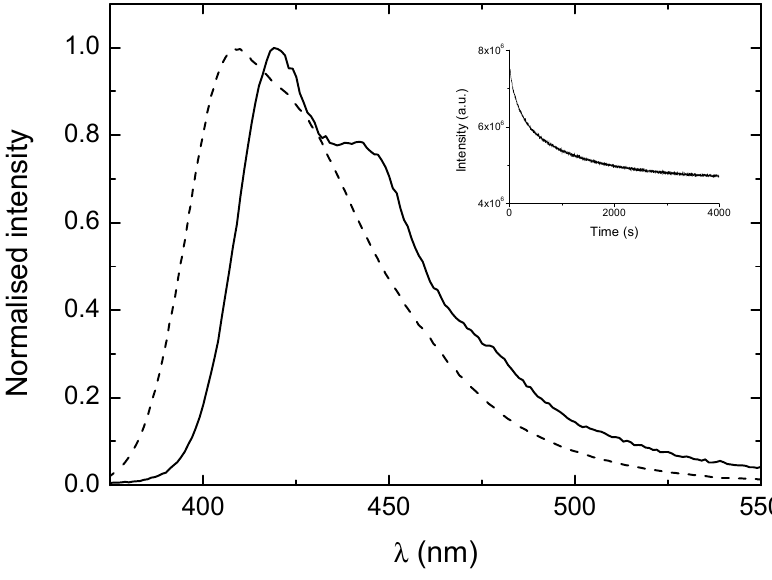
Figure 6. Fluorescence spectra of PBS-PFP3 in water (solid line) and 50% methanol-water (dashed line) solutions. Inset: Changes in fluorescence intensity resulting from aggregation on injecting a solution of PBS-PFP3 (in 50% methanol-water) into water.